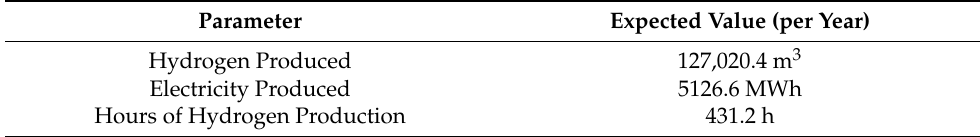
JPY/m 3 using synthetic price inputs. Table 4. Expected dispatch values for the system at a levelized hydrogen cost of 67.5 JPY/m 3